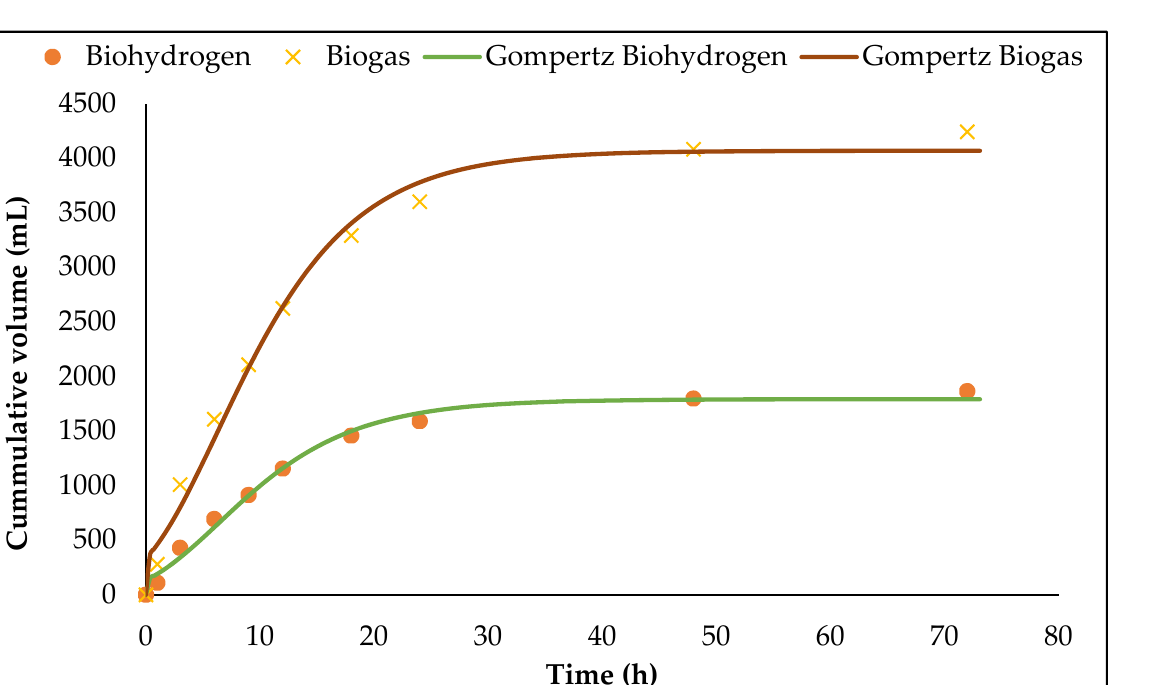
hydrolysate in 1.5 L ACBR fitted in the Gompertz